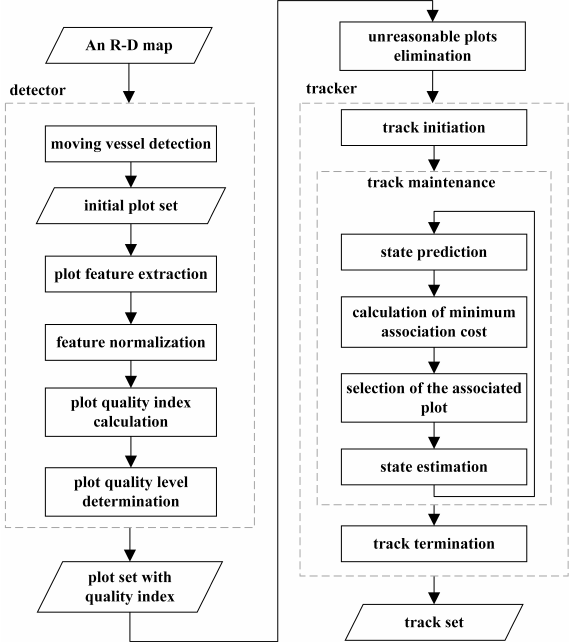
Figure 6. The flowchart of the proposed plot-to-track association